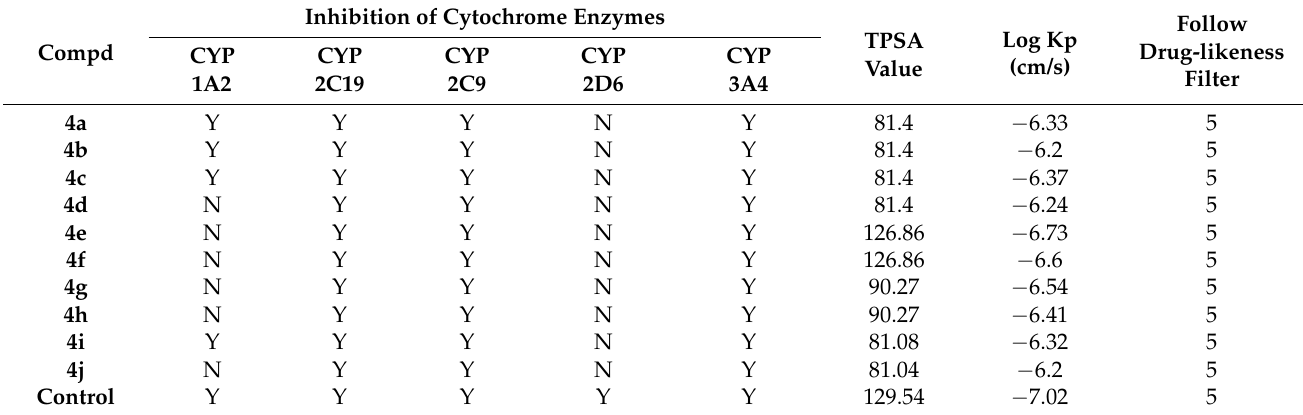
Table 5. Key computational calculations of derivatives 4a – j